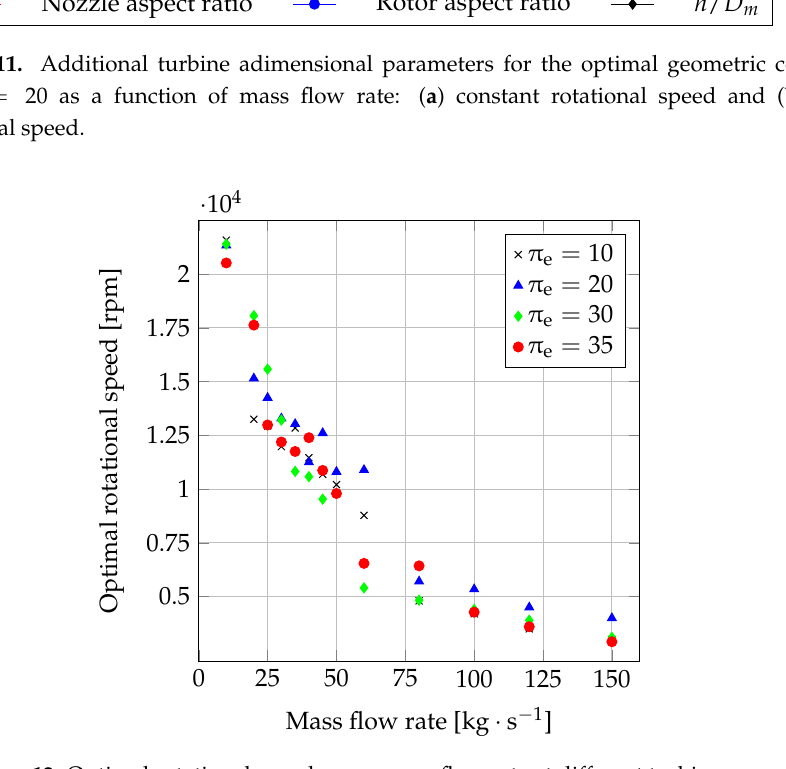
Figure 12. Optimal rotational speed versus mass flow rate at different turbine pressure